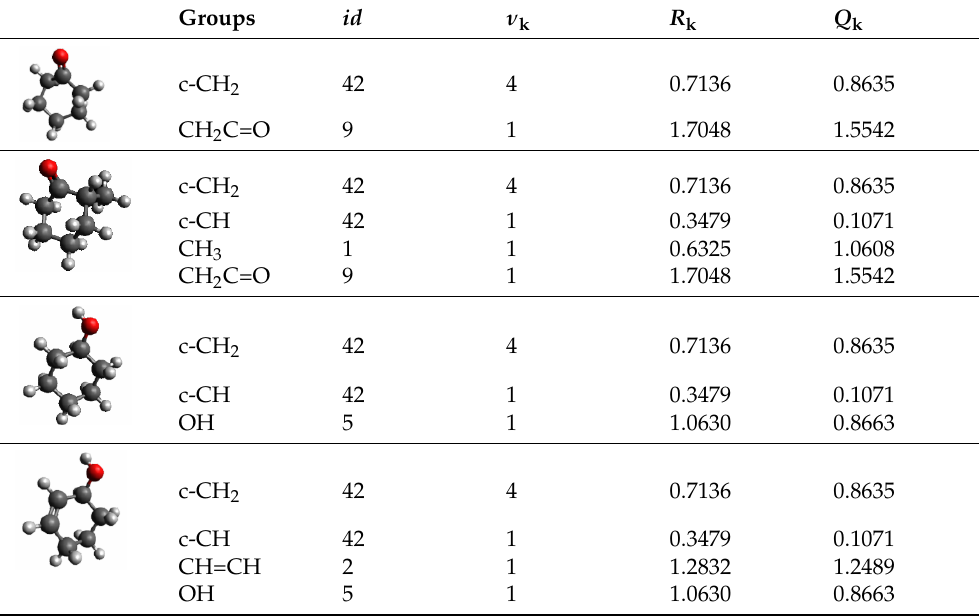
Table A3. UNIFAC groups — volume and surface parameters [5].